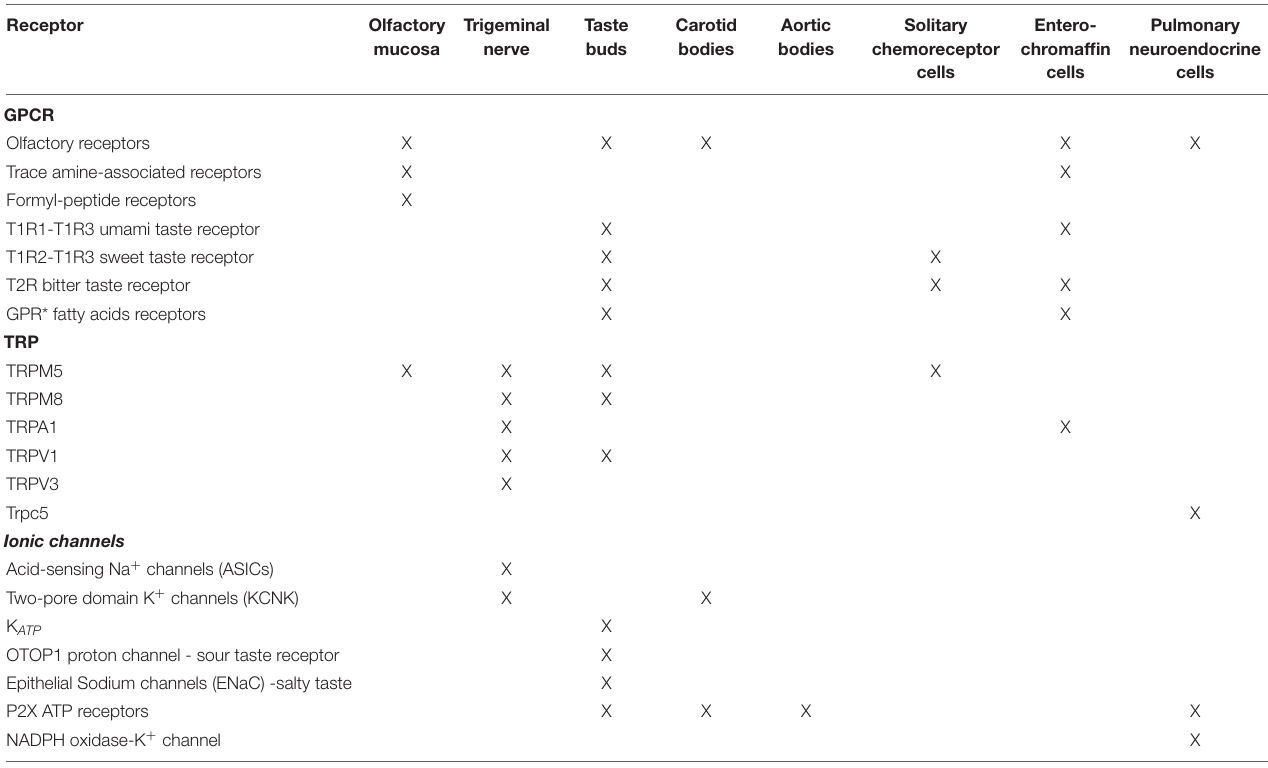
TABLE 1 | Main receptor types expressed in the different peripheral chemosensory structures. Receptor Olfactory